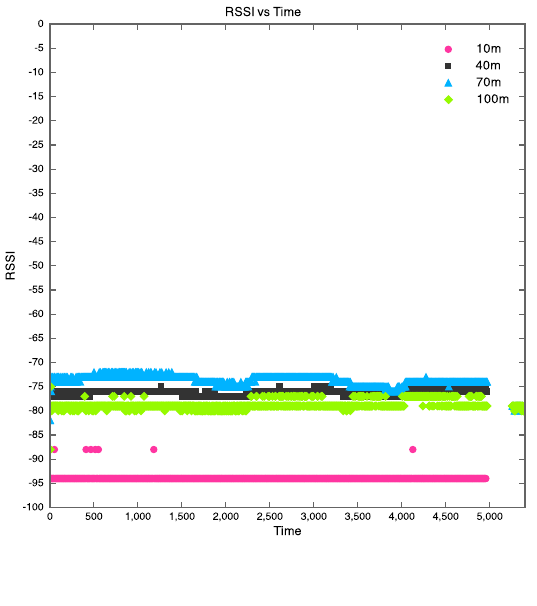
Figure 13. RSSI vs Time for different transmit powers for Experiment 3.